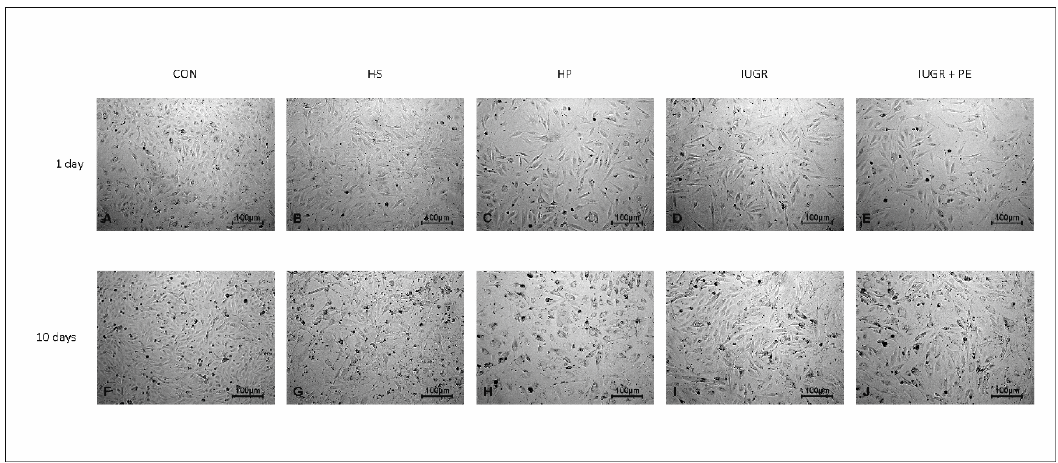
Figure 4. Light microphotographs of human umbilical vein endothelial cell (HUVEC) line EA.hy926 after one and ten days of exposition to medium supplemented with 10% v/v human pooled serum taken from: healthy non pregnant women with matched age (HS), healthy pregnant women (HP), pregnant women with intrauterine growth restriction (IUGR), pregnant woman with both intrauterine growth restriction and preeclampsia (IUGR + PE), and to standard medium supplemented with 10% v/v fetal bovine serum (CON). Magnification 100×.